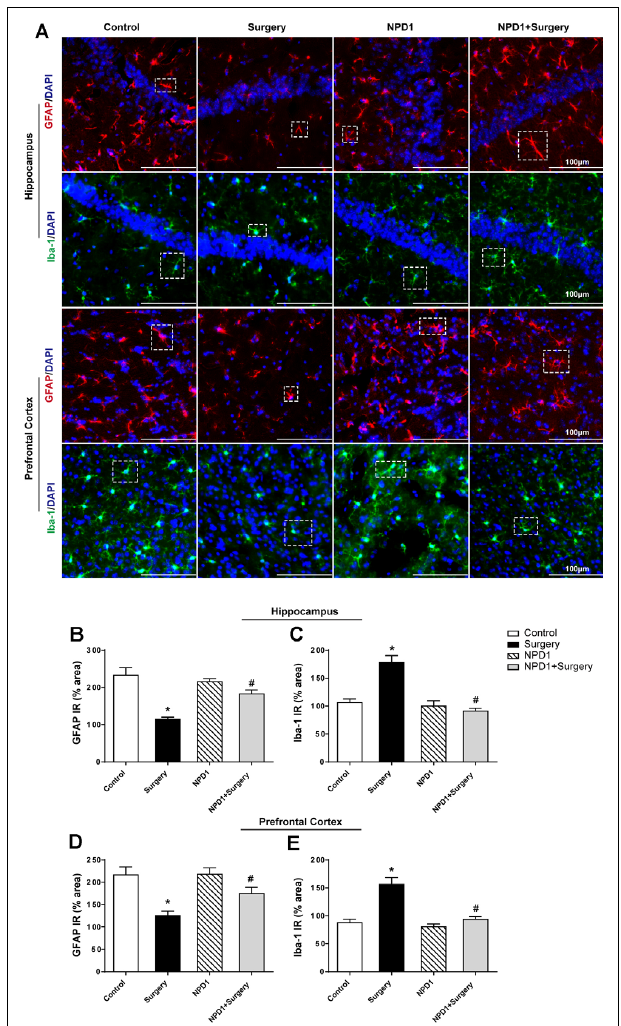
FIGURE 5 | NPD1 pretreatment reverses the activation of astrocytes and microglia in the hippocampus and prefrontal cortex elicited by surgery/anesthesia. Representative images of immunofluorescence showed the expression of glial fibrillary acidic protein (GFAP) and Iba-1 in the hippocampus and prefrontal cortex at 24 h after surgery (A) . Surgery/anesthesia caused distinct changes in the morphology of glial cell, including shortened processes and a reduced cell soma in astrocytes and an amoeba-like morphology in microglia. Preemptive administration of NPD1 significantly restored the classic stellate shape of astrocytes and the ramified shape of microglia. Quantification results of immunostaining at 24 h after surgery shown in (B–E) . Data are presented as mean ± SEM. Statistics: two-way ANOVA followed by Bonferroni post hoc comparison. (B–E) n = 4–5 per group. * P < 0.05 vs. the control group, # P < 0.05 vs. the surgery group. Scale bars represent 100 µ m in (A)